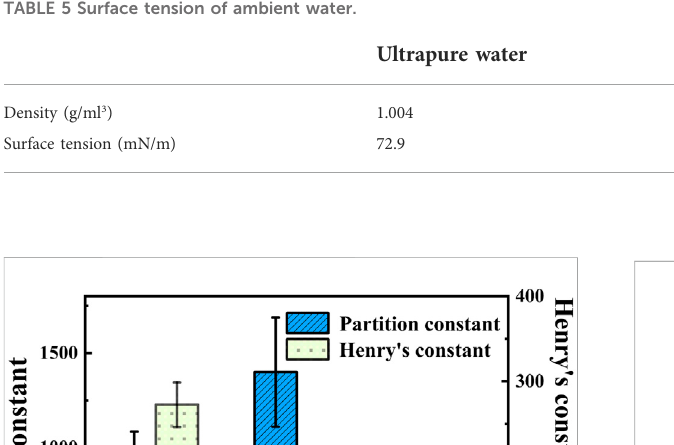
TABLE 5 Surface tension of ambient